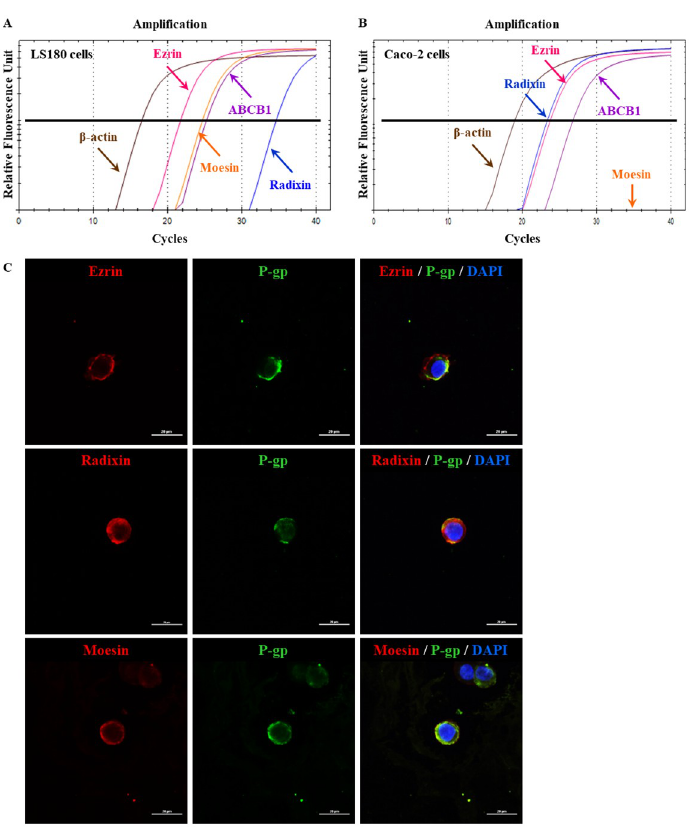
Fig 1. Gene expression pattern and subcellular localization of ezrin, radixin, and moesin (ERM) and P-gp in LS180 cells. (A, B) Representative amplification curves of ezrin, radixin, moesin, and ABCB1 together with that of β - actin (internal control) in LS180 and Caco-2 cells as determined by real-time quantitative reverse transcription- polymerase chain reaction. (C) Confocal laser scanning microscopy analysis of ERM and P-gp to visualize the subcellular distribution in LS180 cells. In a three-dimensional reconstruction of optically sectioned LS180 cells, ezrin, radixin, and moesin (red) were detected on the plasma membrane and preferentially colocalized with P-gp (green) on the plasma membrane. Scale bars: 20 μ m. All data are representative of at least three independent